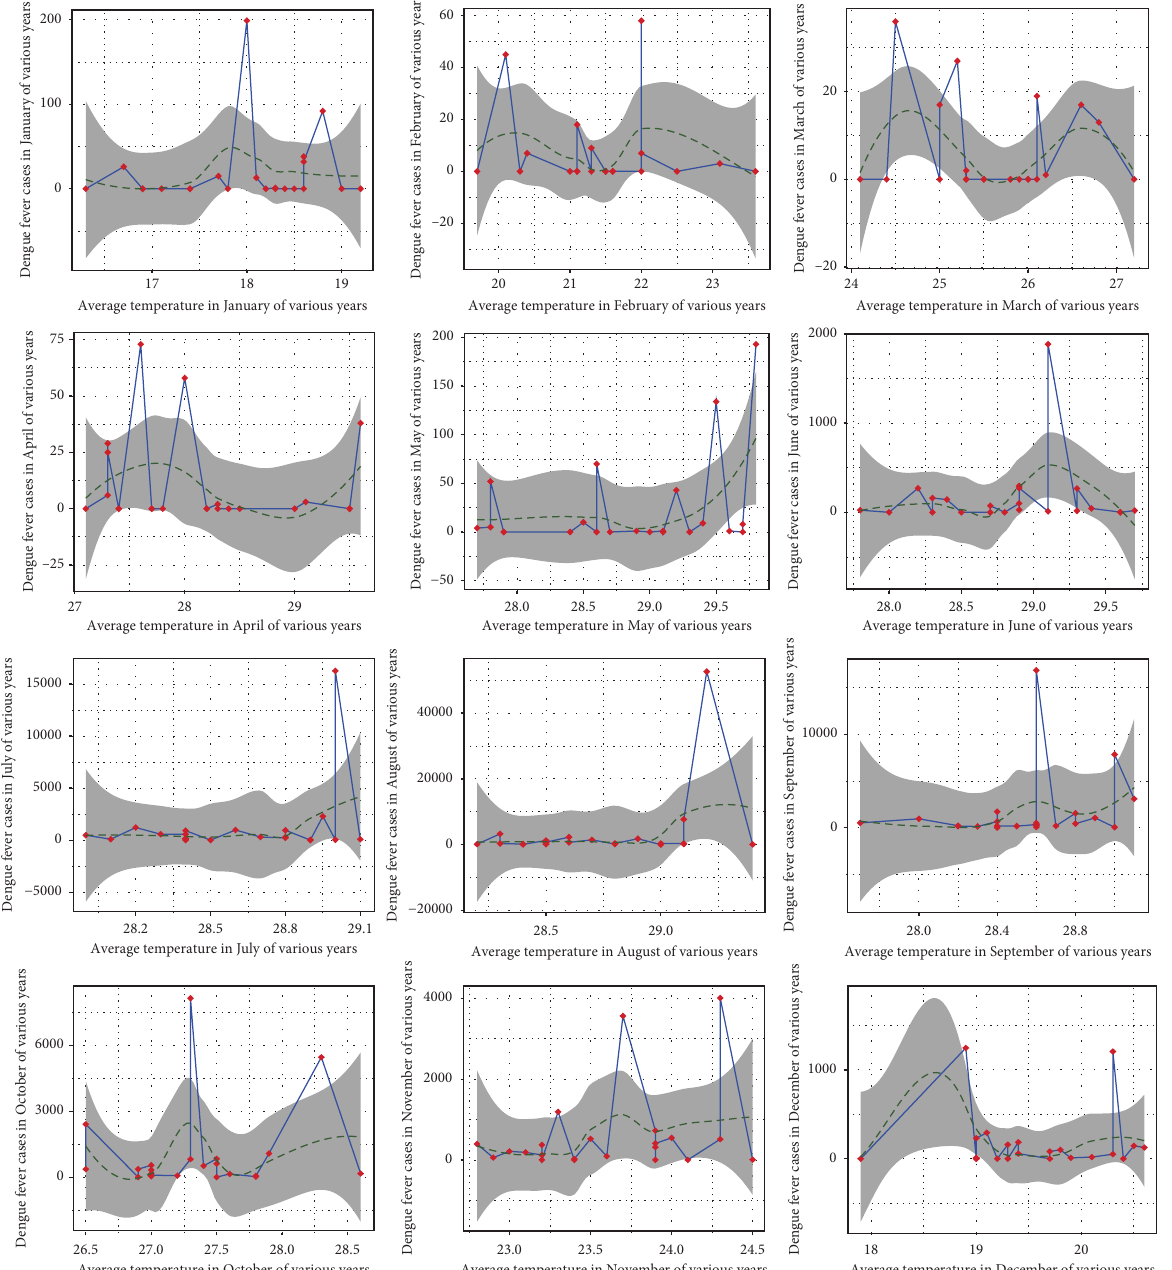
Figure 1: Te impact of the daily average temperature on monthly dengue cases. Dots represent monthly dengue cases at diferent values of the daily average temperature in that particular month of diferent years. A LOESS smoothing function is used to obtain a smooth line representing the trend of dengue cases for diferent average temperature values for a particular month over the years. Te shaded area denotes the 95% confdence interval of monthly dengue cases at the diferent daily average temperatures for that month over the